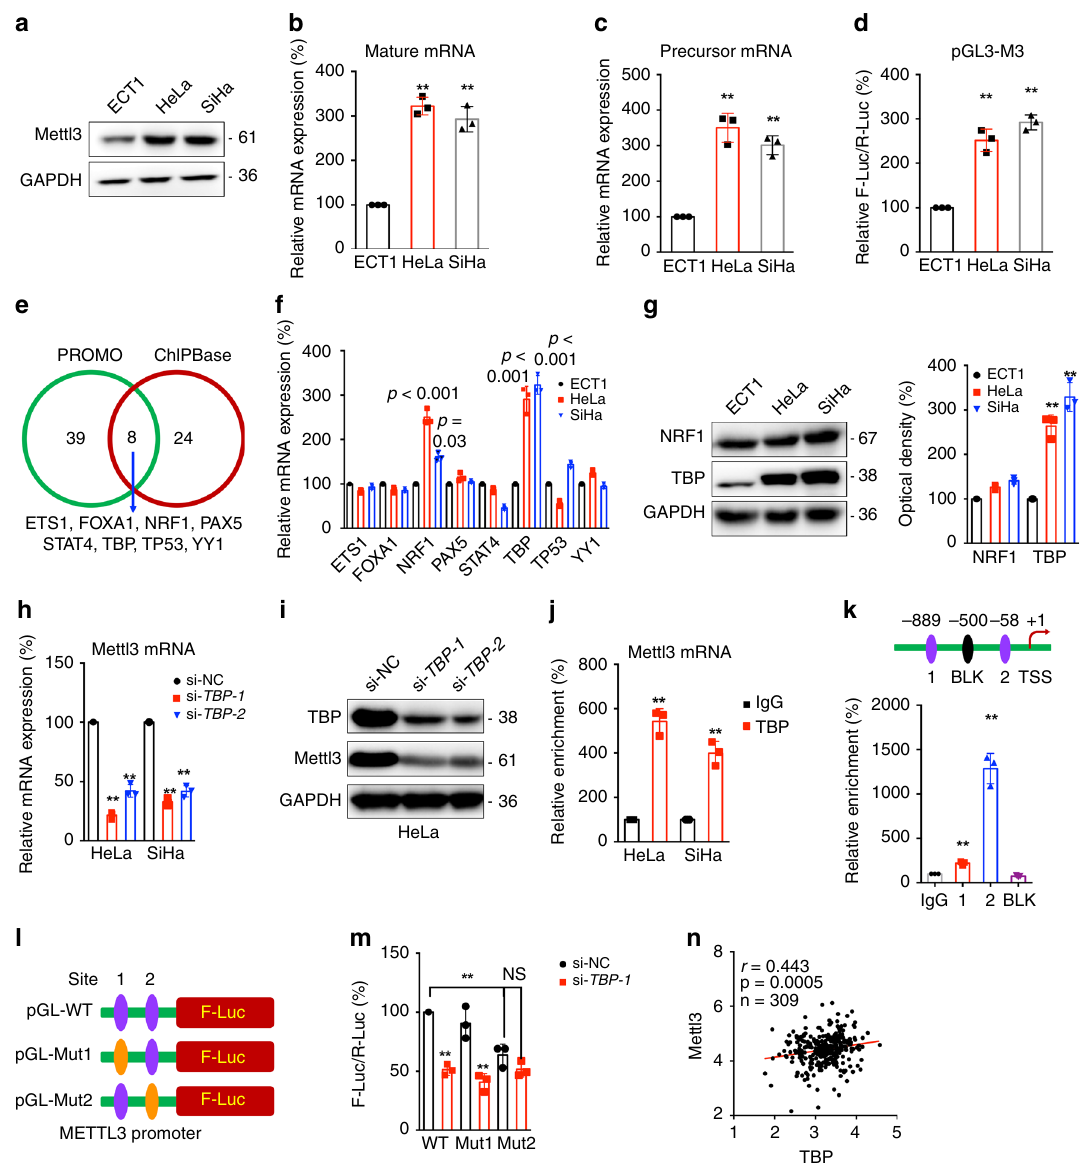
Fig. 7 TBP is responsible for the upregulation of Mettl3 in cervical cancer cells. a – c The protein ( a ), mature mRNA ( b ), or precursor mRNA ( c ) of Mettl3 in ECT1/E6E7, HeLa, and SiHa cells were checked. d The promoter activities of Mettl3 in ECT1/E6E7, HeLa, and SiHa cells were checked by dual-luciferase assay. e Venn diagram shows the overlap of transcription factors of Mettl3 predicted by PROMO and ChIPBase, respectively. f The mRNA expression of potential transcription factors of Mettl3 in ECT1/E6E7, HeLa, and SiHa cells were checked by qRT-PCR analysis. g The protein expression of NRF1 and TBP was checked by western blot analysis ( left ) and quantitatively analyzed ( right ). h , i Cells were transfected by siRNA negative control (si-NC) or siRNAs of TBP for 24 h, the mRNA ( h ) and protein ( i ) levels of Mettl3 were checked. j The binding between TBP and promoter of Mettl3 was checked by ChIP-PCR using IgG or TBP antibody. k Binding between TBP transcriptional factor and the promoter of Mettl3 at the potential binding site 1 and 2 or negative site BLK was checked by ChIP-PCR. l Schematic representation of the mutated promoter in pGL3-Basic-Mettl3-luc reporter to investigate the role of TBP in Mettl3 expression. m HeLa cells were co-transfected with pGL3-Mettl3-WT-Luc, pGL3-Mettl3-Mut1-Luc, pGL3-Mettl3-Mut2-Luc, pRL-TK plasmid and si-NC or si-TBP-1 for 24 h. Results were presented as the ratio between the activity of the reporter plasmid and pRL-TK. n Correlation between Mettl3 and TBP in cervical cancer patients ( n = 309) from ChIPBase database. Data are presented as the mean ± SD from three independent experiments. ** p < 0.01. NS, no signi fi cant, by one-way ANOVA for ( b ) ( p < 0.001 for all), ( c ) ( p < 0.001 for all), ( d ) ( p < 0.001 for all), ( f , g ) ( p < 0.001 for all), and ( h ) ( p < 0.001 for all), two-tailed unpaired Student ’ s t test for ( j ) ( p < 0.001 for all), ( k ) ( p < 0.001 for all), and ( n ) ( p = 0.0005), and by two-way ANOVA for ( m ) ( p < 0.001 for